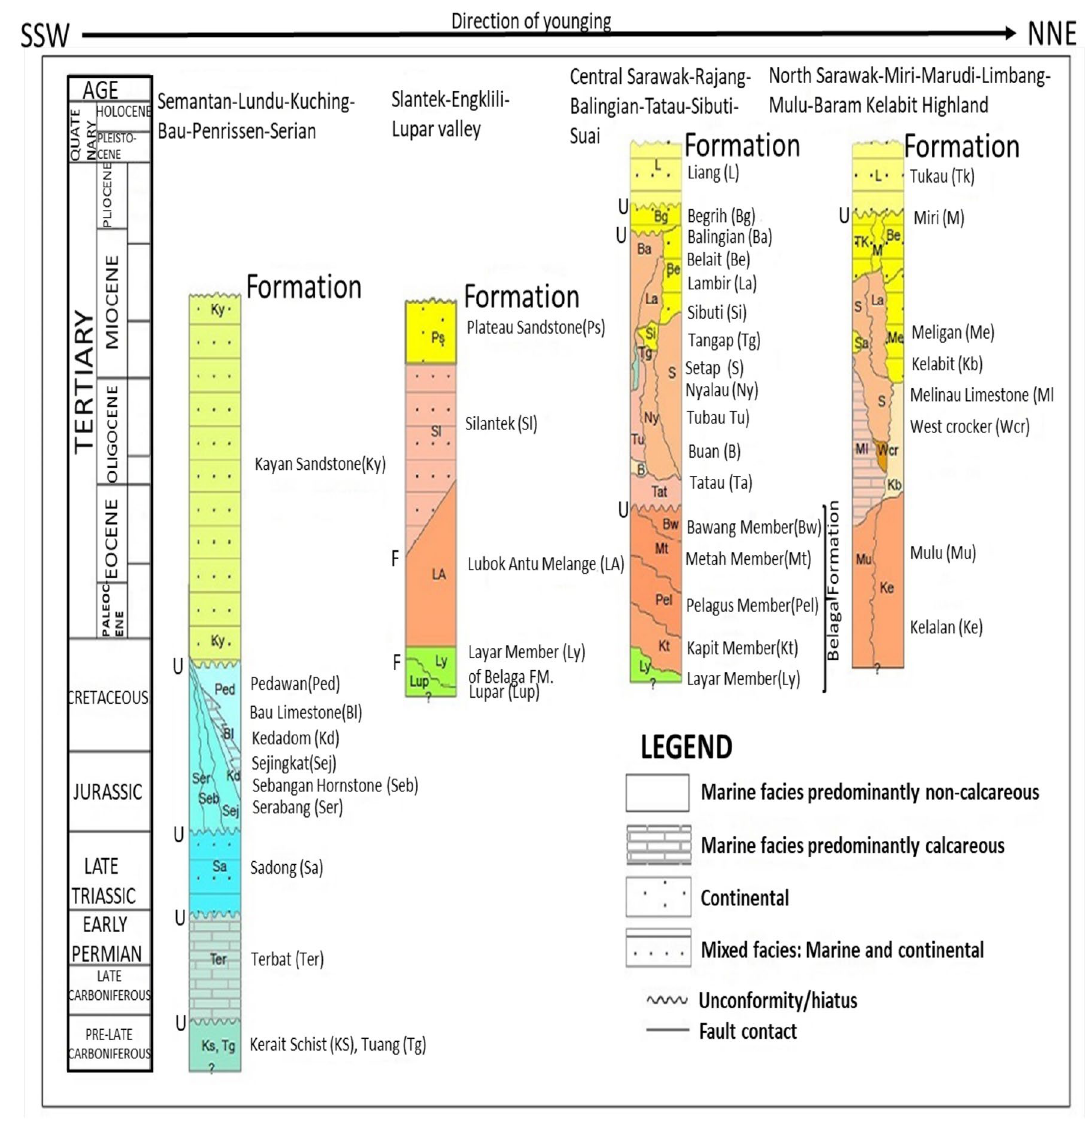
Fig. 4 Overview of onshore Sarawak stratigraphy. Alphabets used in logs represent formation names, which are displayed adjacent to each formation. Note the upward younging from the Kerait Schist in